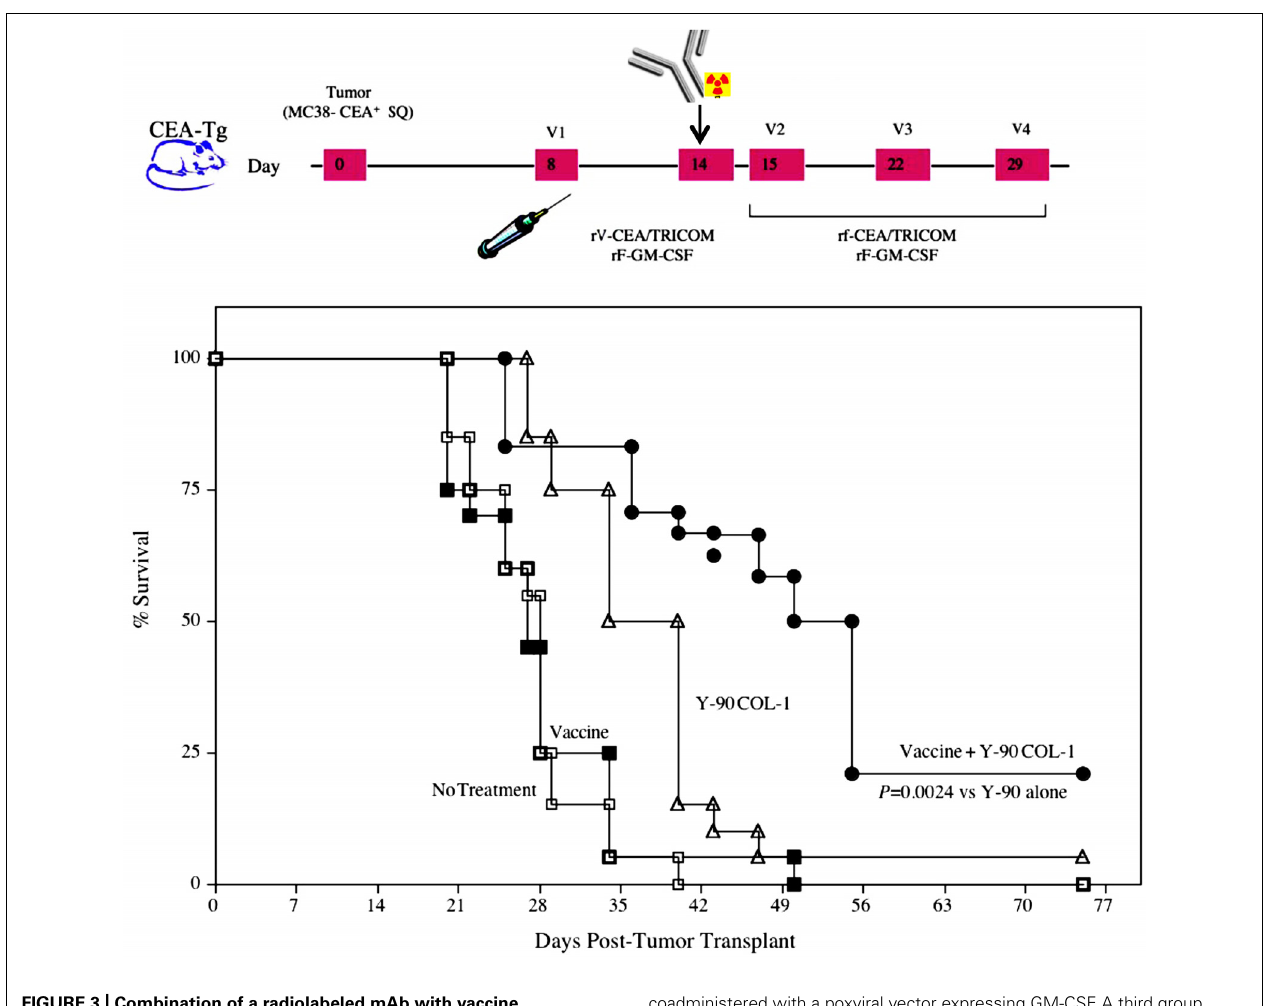
FIGURE 3 | Combination of a radiolabeled mAb with vaccine increased survival in tumor-bearing mice. Mice transgenic for CEA were implanted subcutaneously on day 0 with the MC38-CEA tumor cell line. A control group (open squares) received HBSS buffer only. A second group (closed squares) received a vaccine consisting of poxviral vectors expressing CEA andTRICOM (rV/F-CEA/TRICOM). All vaccines were